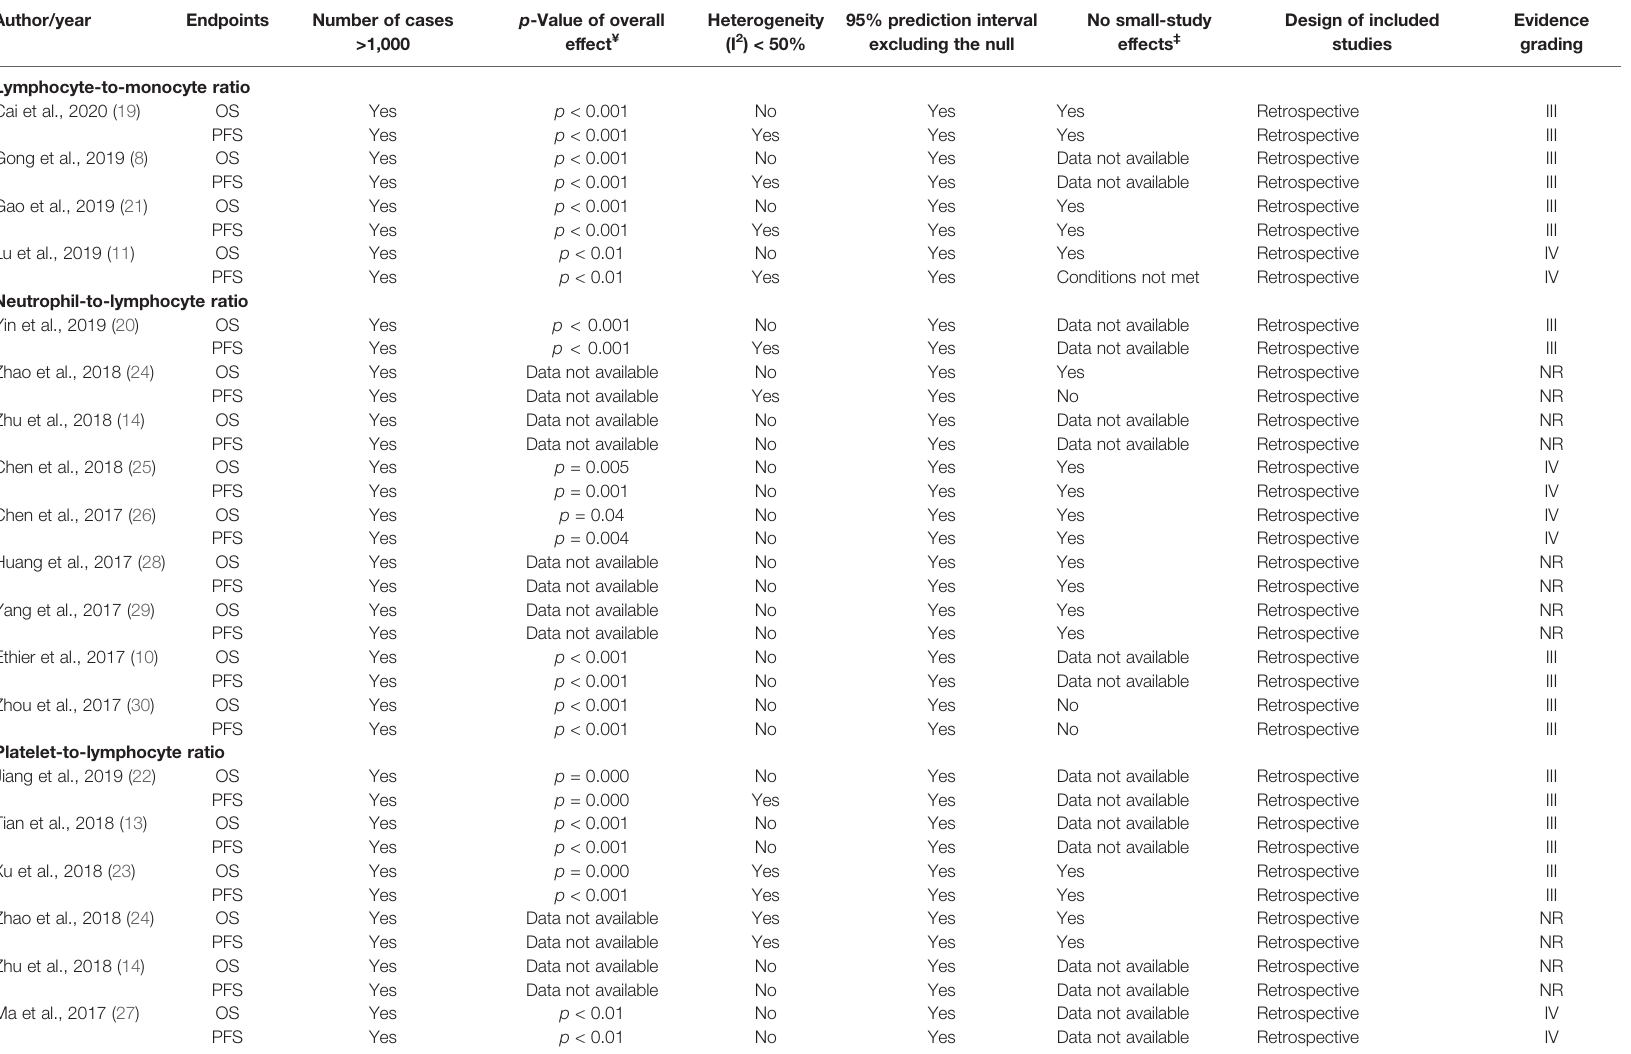
TABLE 5 | Evidence grading of appraised